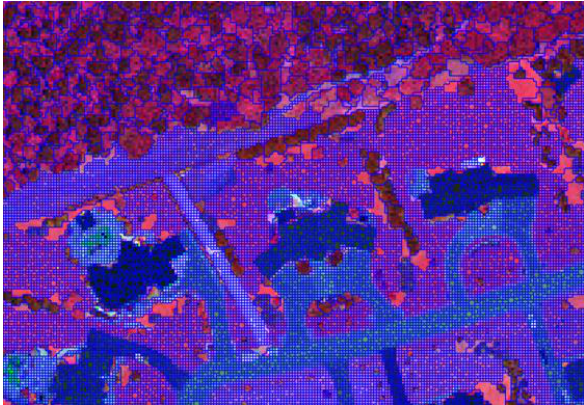
Figure 3. Results of twice multi-resolution segmentation using different scale parameter 5 and